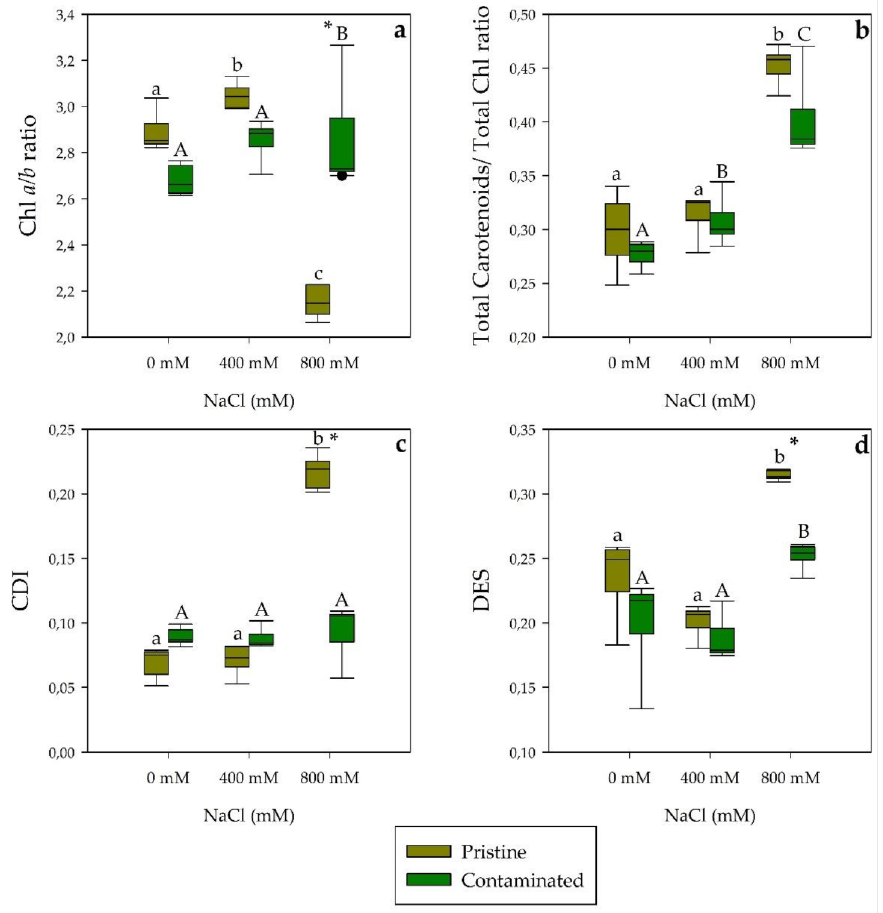
Figure 5. Leaves pigment ratios, ( a ) chlorophyll a / b ratio (Chl a/b ratio), ( b ) total carotenoid to total chlorophyll ratio, ( c ) chlorophyll degradation index (CDI), and ( d ) de-epoxidation state (DES) in S. patens individuals from pristine and heavy metal contaminated sites (average ± standard error, N = 5), along with the tested NaCl concentrations. Letters indicate significant differences between treatments at p < 0.05; asterisks mark significant differences between populations at p <